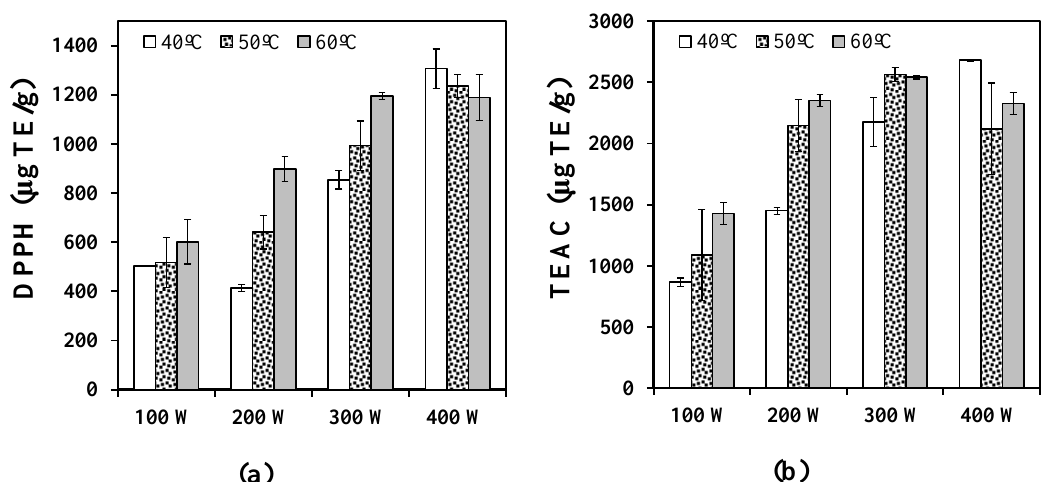
Figure 4. Thermosonication effects on the antioxidant activity of fennel extracts obtained by thermosonication using the ( a ) DPPH radical and ( b ) TEAC methods.